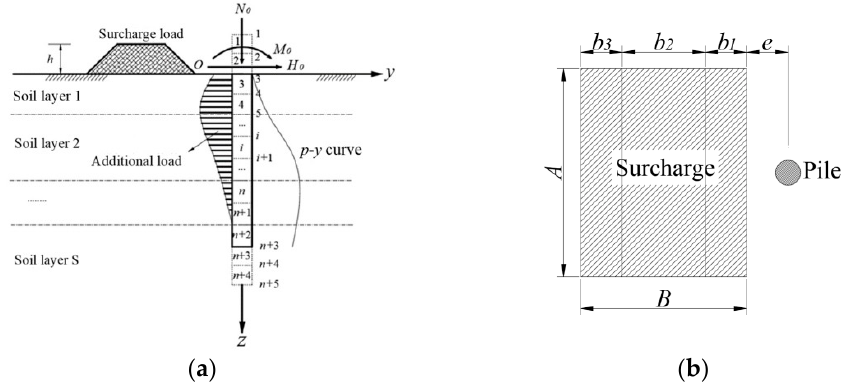
Figure 1. Calculation model diagram of a single pile using our coordinate system. ( a ) Elevation; ( b ) plane.